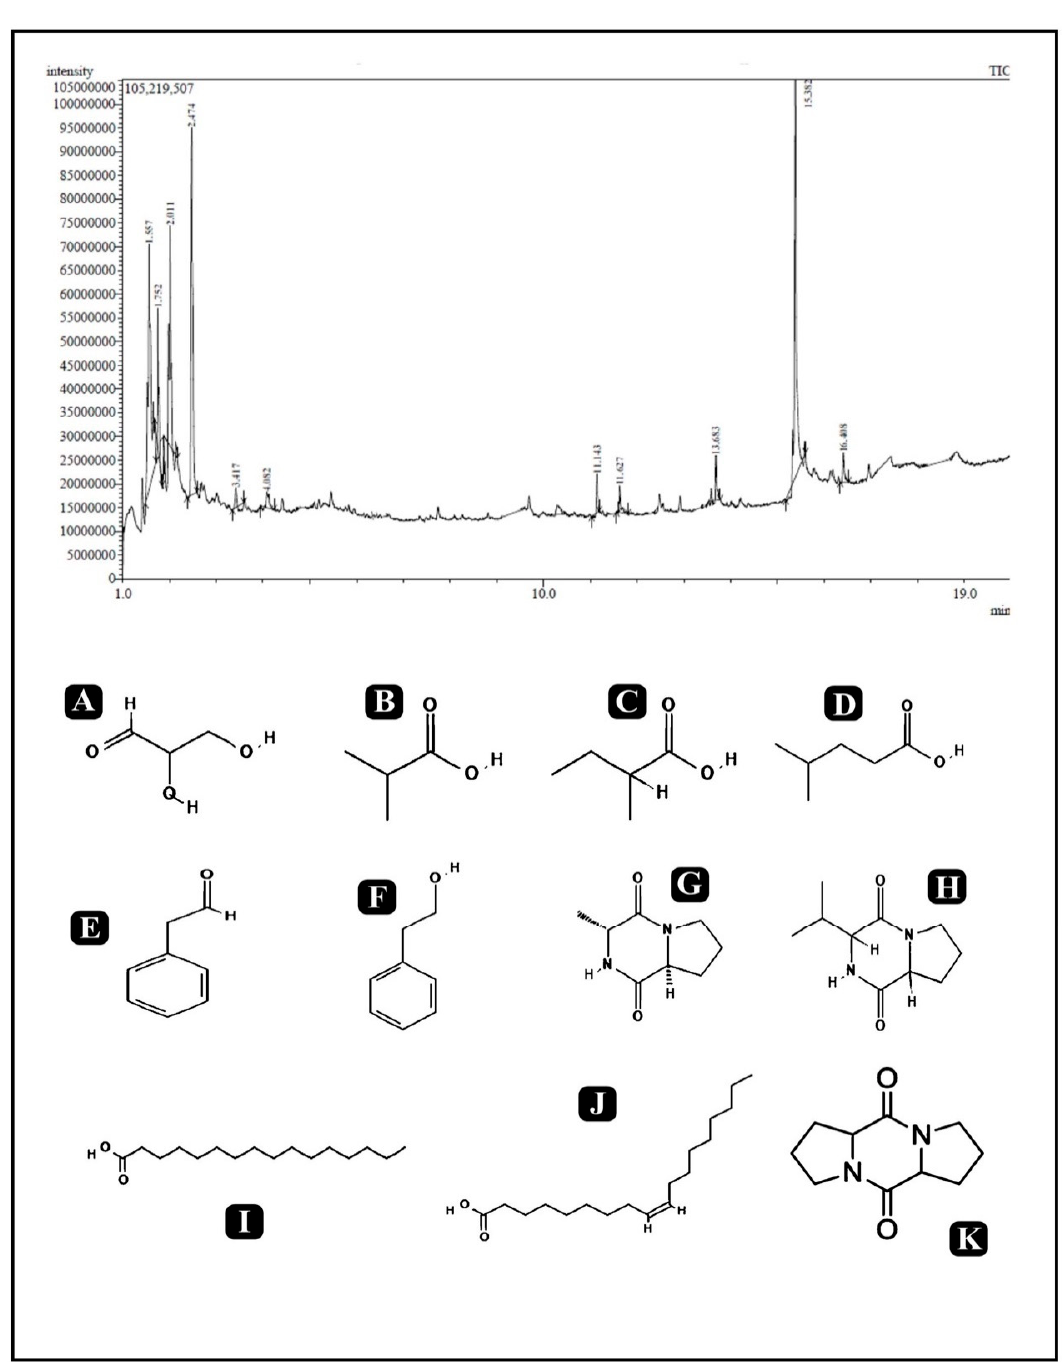
Figure 9. GC-MS analysis of crude biosurfactant derived from P. pentosaceus. Identified compounds. ( A ) Glyceraldehyde, ( B ) Propanoic acid, 2-methyl-, ( C ) Butanoic acid, 2-methyl-, ( D ) Pentanoic acid, 4-methyl-, ( E ) Benzeneacetaldehyde, ( F ) Phenylethyl Alcohol, ( G ) (Cyclo(- D -Ala-L-Pro)), ( H ) (Cyclo(-Pro-Val)), ( I ) n-Hexadecanoic acid, ( J ) Oleic Acid, and ( K ) Octahydro-5H, 10H-dipyrrolo [1,2-a:1 ′ ,2 ′ -d]pyrazine-5,10-dione.